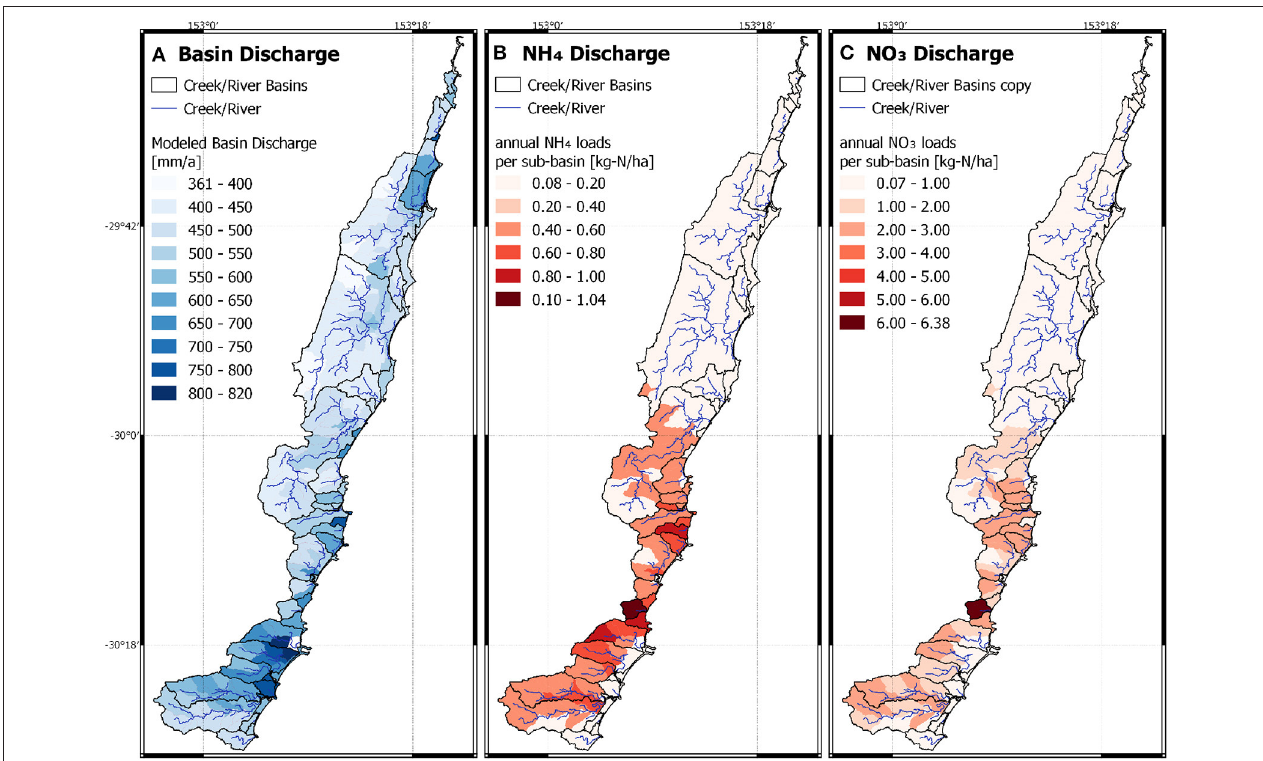
FIGURE 6 | Model result of the extrapolation of the calibrated Bucca Bucca catchments applied on the study area. (A) Averaged annual discharge into creeks by immediate surface runoff and interflow. (B) Averaged annual discharge of ammonium into creeks. (C) Averaged annual nitrate discharge into creeks.